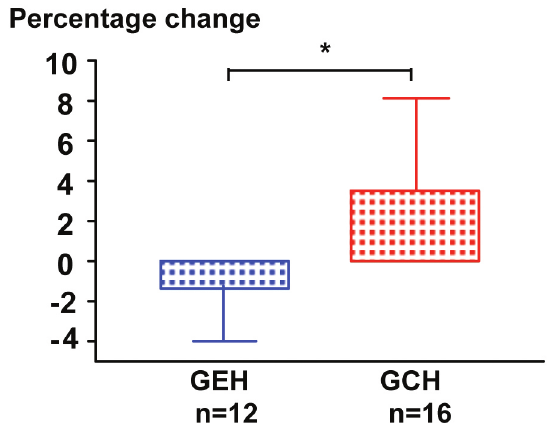
FIGURE 3 - Percentage change ± SD of the waist/hip ratio between time 0 and 270 (days), in the hypertensive experimental group (EGH) and hypertensive control group (CGH). *p=0.001. EGH n=12 (12 patients of the hypertensive experimental group provided measures needed for comparisons). CGH n=16 (16 patients of the hypertensive control group provided measures needed for comparisons).